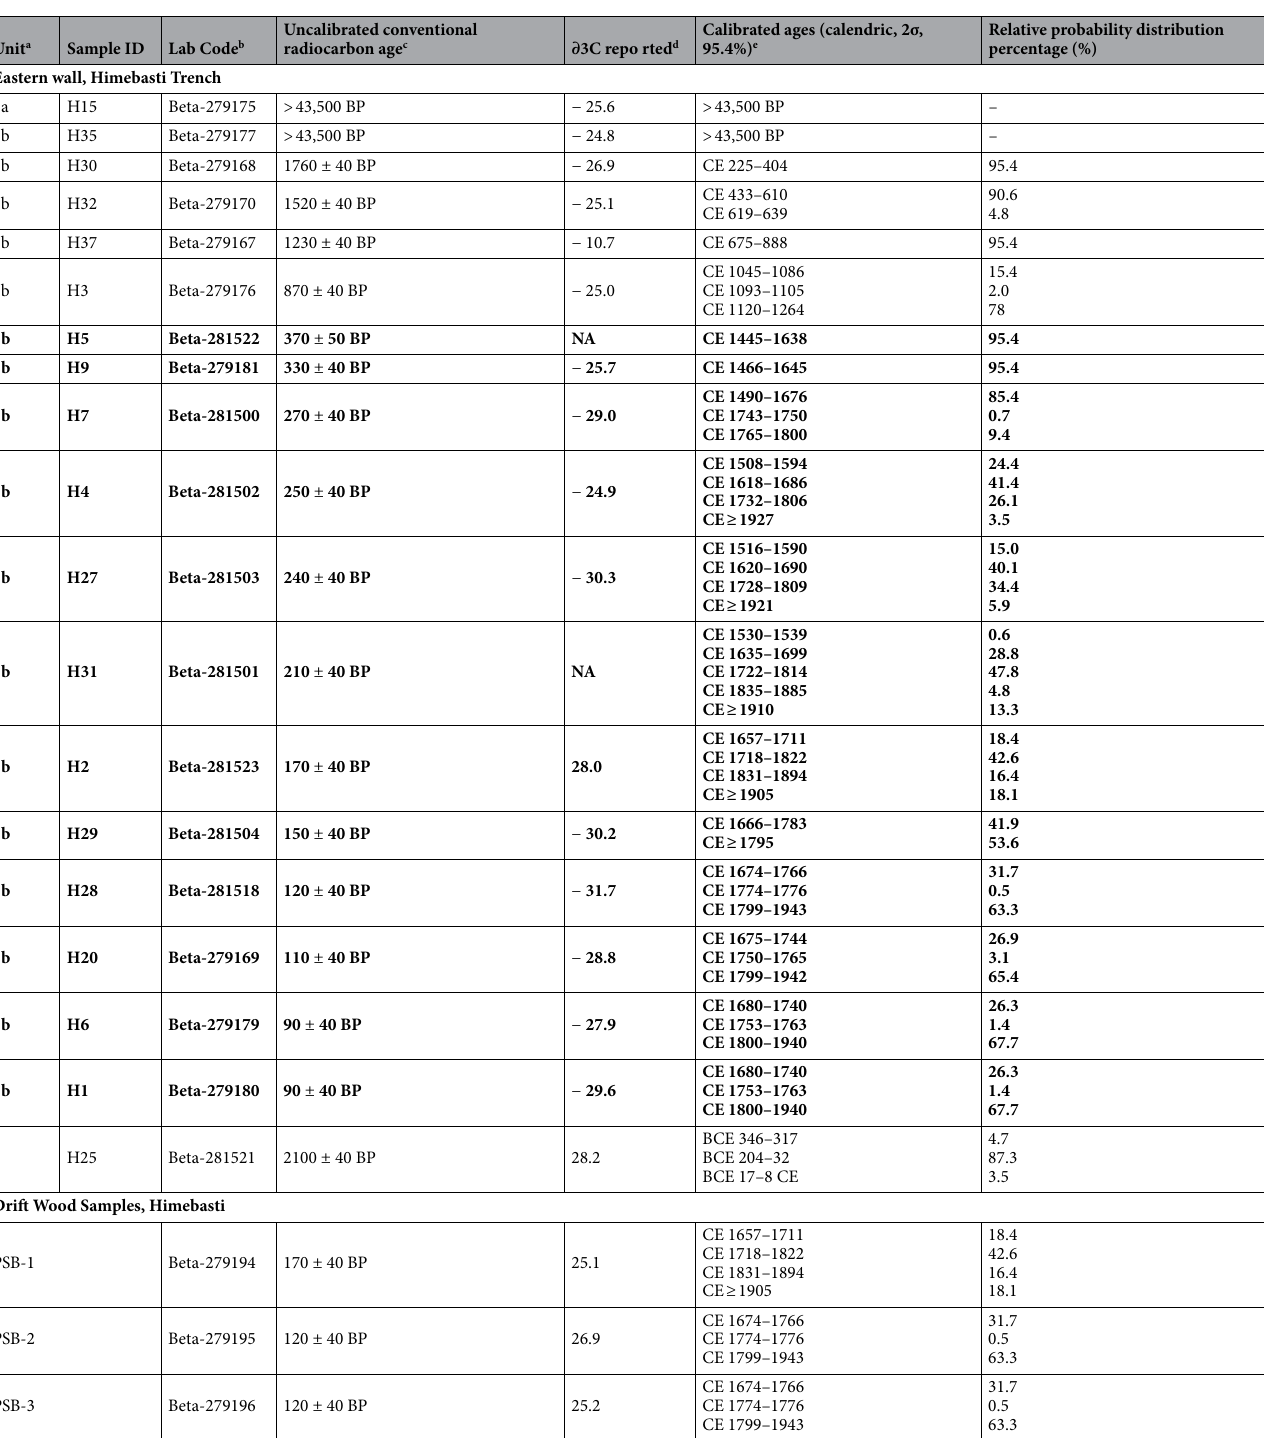
Table 1. AMS Radiocarbon ( 14 C) dates from detrital charcoals collected from the Himebasti trench. PSB1, 2 and 3, are buried wood logs. All other samples are detrital charcoals. a Refer to respective trench logs for stratigraphic unit designations. b Samples have been analyzed at Beta Analytic (Florida) by accelerator mass spectrometry (AMS). Each number corresponds to the laboratory code for each sample. c Conventional Radiocarbon years BP relative to 1950 CE with 2σ confidence level comprising of counting statistics, reference standard, blank, and random machine error. d The δ13C values are the assumed values when given without decimal places. Values measured for the material itself are given with a single decimal place. e Pre-bomb calendric dates were calibrated using OxCal v4.4.2 (https ://14C.arch.ox.ac.uk/oxcal /OxCal .html) 21